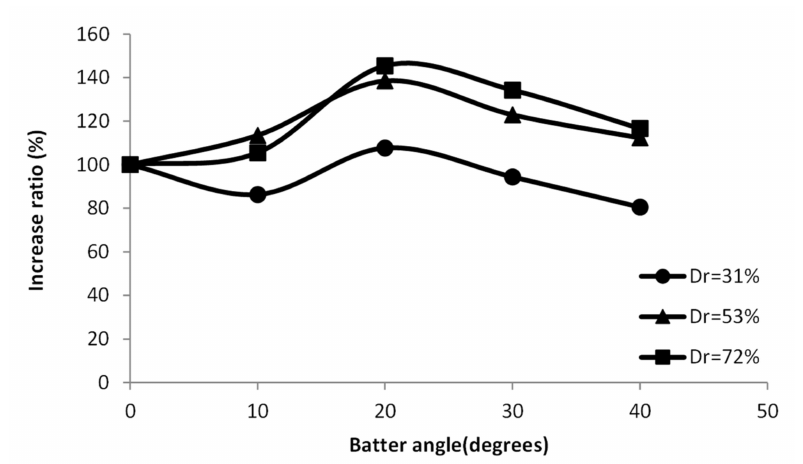
Figure 7. Comparison of bearing